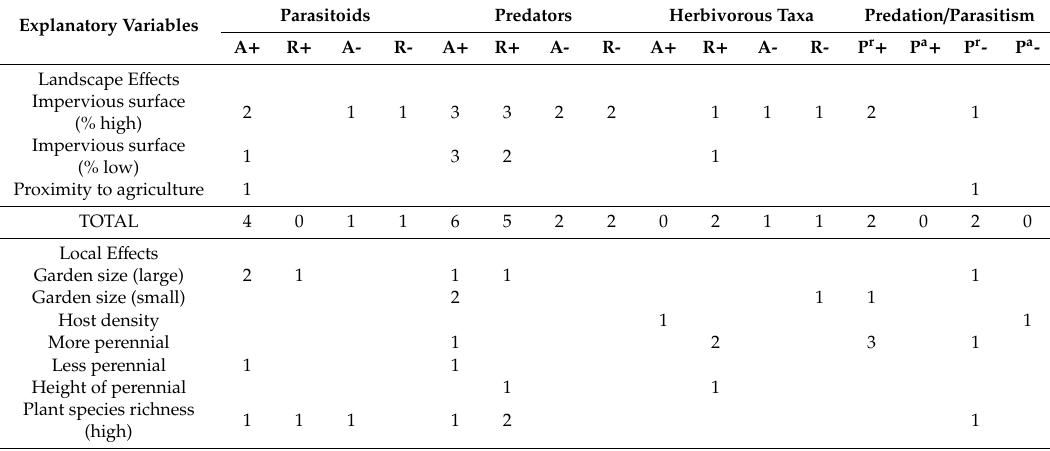
Table 1. Explanatory variables from local and landscape e ff ects that were categorized from the literature review of 15 articles on their positive / increasing ( + ) or negative / decreasing (-) impact on species Abundance (A) and Richness (R) of parasitoids, predators, herbivores, and ecosystem services predation (P r ), and parasitism (P a